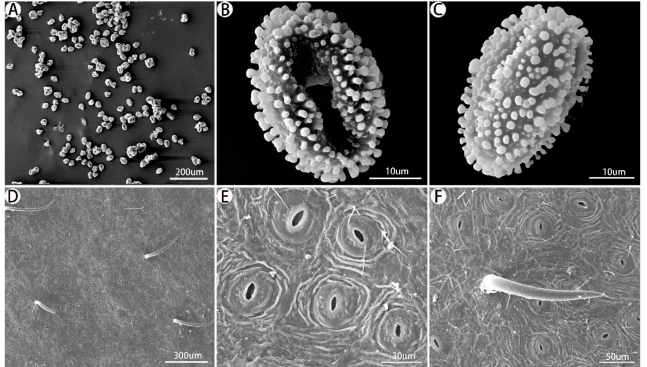
Figure 4. SEM photomicrographs of pollen grains and stomata of Ilex danxiaensis sp. nov.